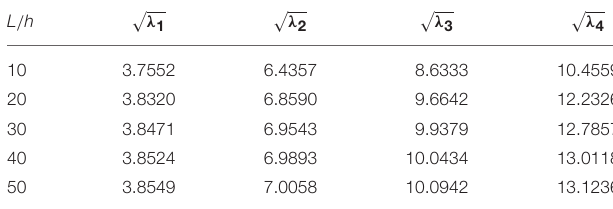
TABLE 22 | Frequency parameters length-to-height ratio.